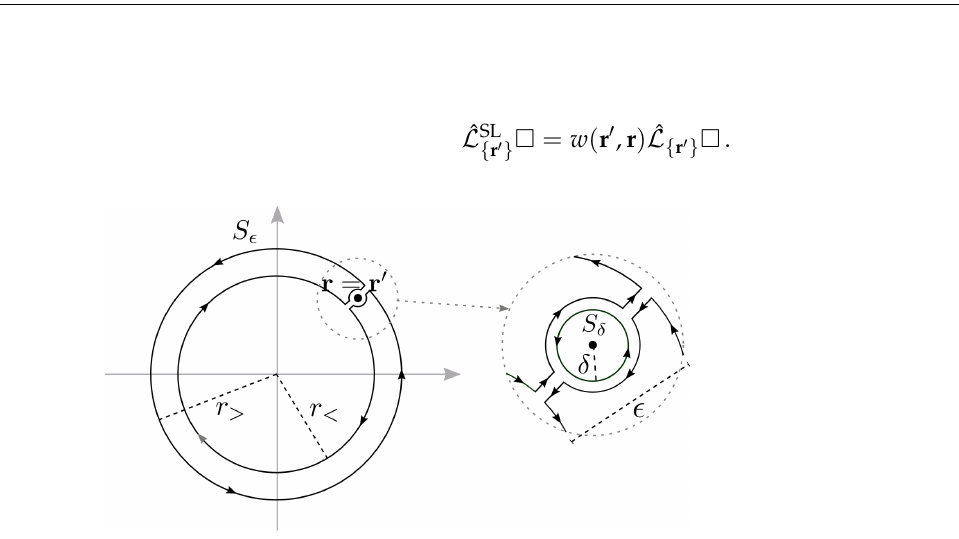
Figure 1. Contours used in the path integration: to the left S (cid:101) and S δ to the right. The radius and thickness are chosen purposely as δ < (cid:101) /2 to take the (cid:101) → 0